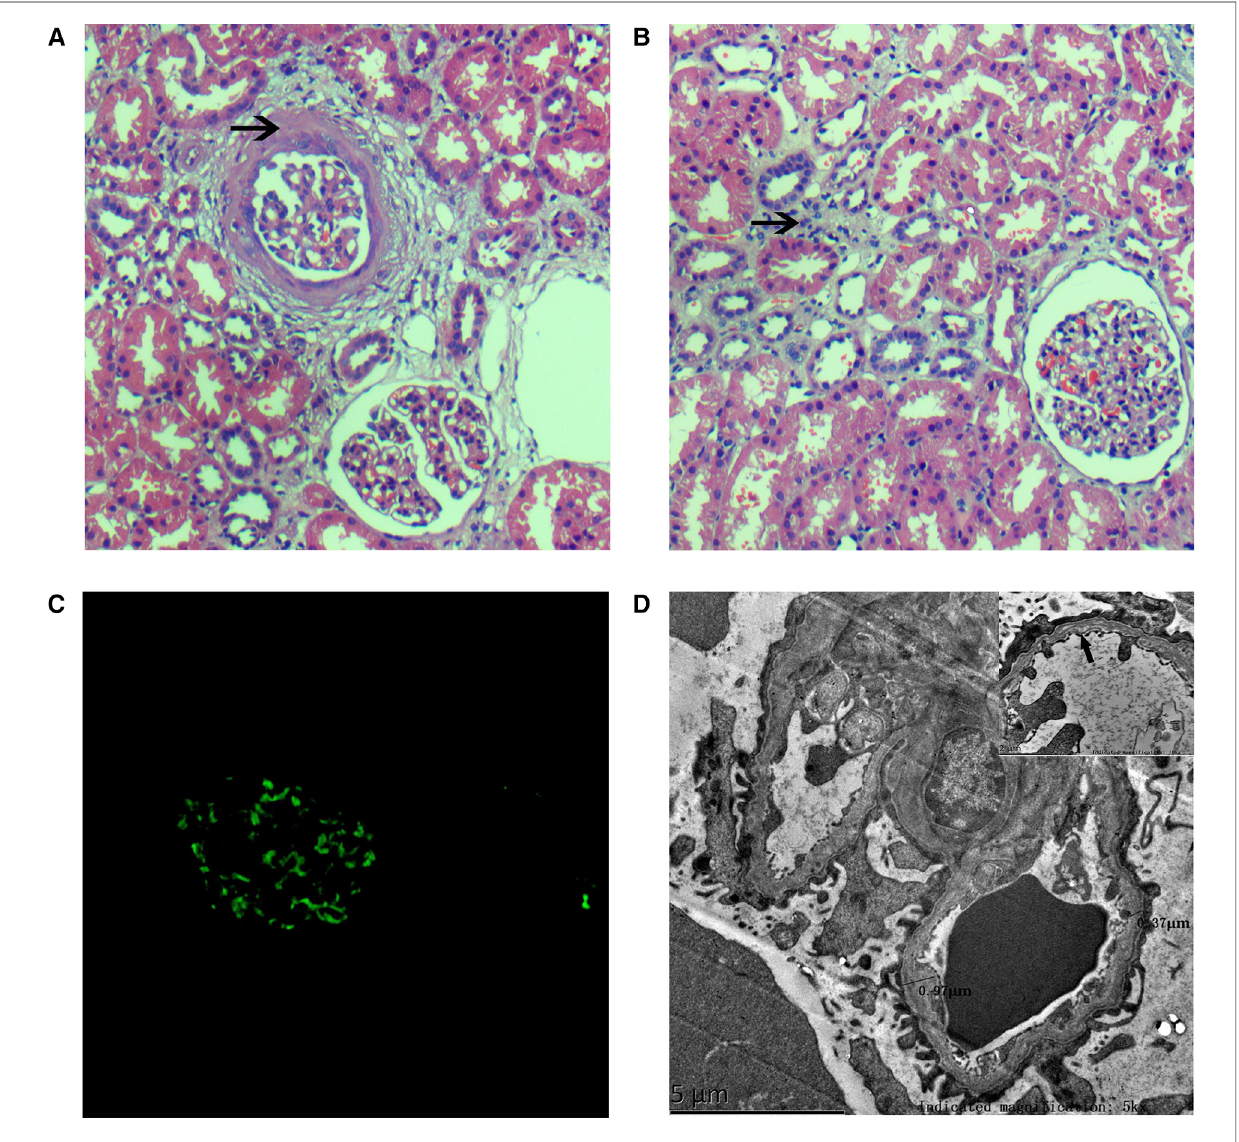
FIGURE 2 Histopathologic lesions. ( A ) H&E stain (×200) showing glomeruli mesangial hypercellularity, a thickened mesangial matrix, and a ring-like mixed crescent form ( ↑ ); ( B ) the renal tubules depicting interstitial in fl ammatory cell in fi ltration and interstitial fi brosis ( ↑ ) by a light microscopy study (H&E stain, ×200); ( C ) immuno fl uorescence staining showing granular deposition of IgM (++) within the mesangium; and ( D ) electron micrograph showing abnormal glomerular capillary basement membrane thickness, uneven thickness, (ranging from 350 to 900 nm), layered ( ↑ ), focal torn, and endothelial cell